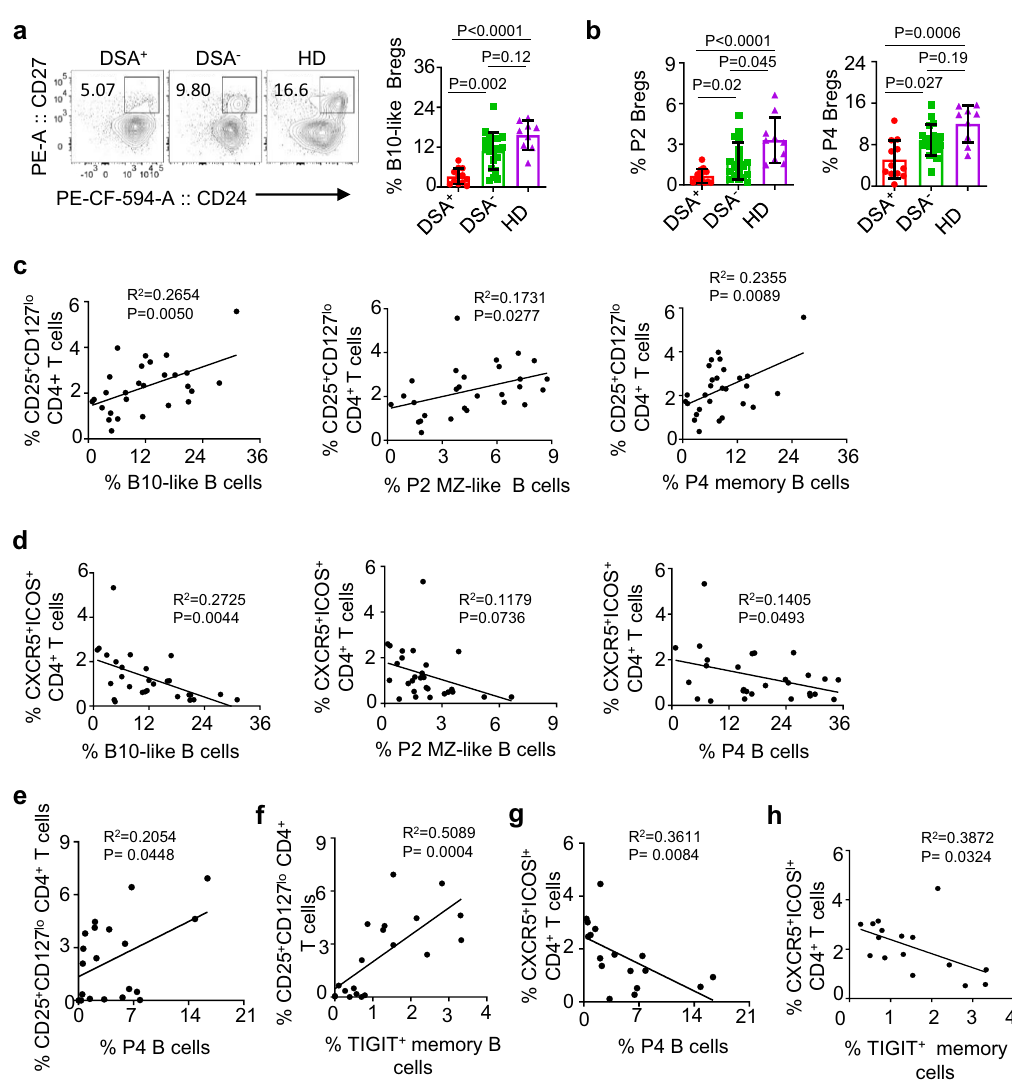
Fig. 8 TIGIT + memory B cells in liver and kidney allograft recipients. a , b Representative FACS plots and summarized data for the frequency of CD19 + CD24 hi CD27 + B10-like Bregs ( a ), and P2 MZ-like and P4 memory B cells ( b ) in the blood of donor-speci fi c antibody (DSA) + ( n = 12) and DSA − ( n = 19) liver transplant patients and healthy controls ( n = 9). Dots represent individual patients. c , d Scatter plots showing the association of the frequency of B10- like, P2 MZ-like, and P4 memory B cells with CD4 + CD25 + CD127 lo Tregs ( c ) and with CXCR5 + ICOS + TFH cells ( d ) in liver allograft recipients. e , f Scatter plots showing the association of the frequency of P4 memory ( e ) and TIGIT + memory B cells ( f ) with that of CD4 + CD25 + CD127 lo Tregs in renal allograft recipients. g , h Scatter plots showing the association of the frequency of P4 memory B cells ( g ) and TIGIT + memory B cells ( h ) with that of CD4 + CXCR5 + ICOS + TFH in renal allograft recipients. Error bars indicate mean ± SD. P values were determined with one-way ANOVA with Dunnett ’ s multiple comparison test ( a , b ). R 2 and P values were calculated using Pearson correlation tests ( c – h